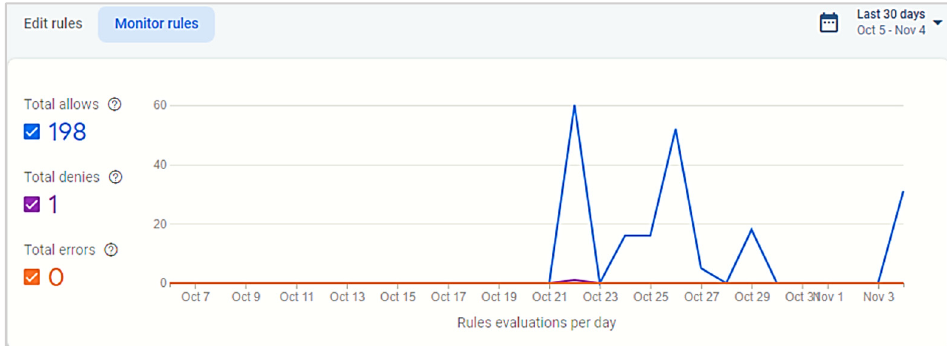
Figure 18. Screenshot of performance of Zamwallet.